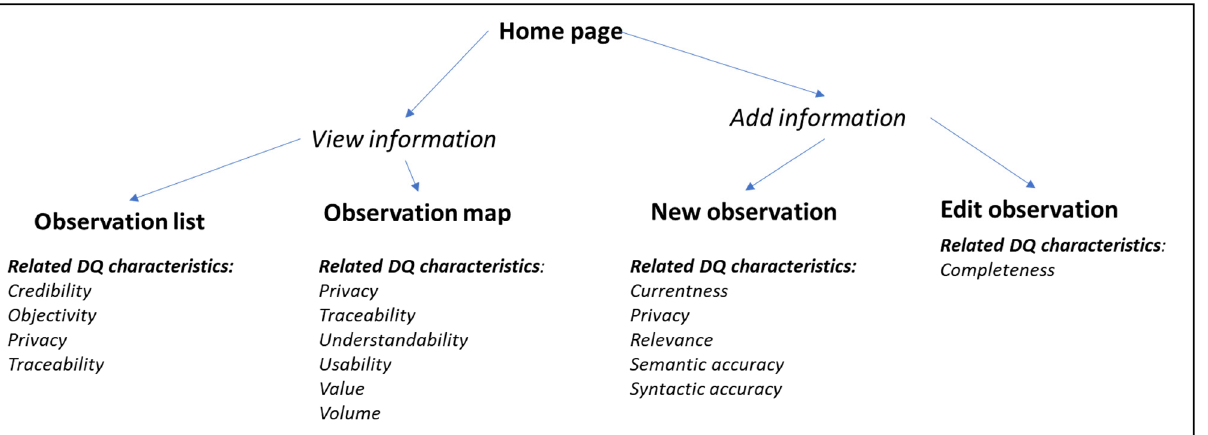
Figure 2. Quality characteristics in WalkingPaths views.